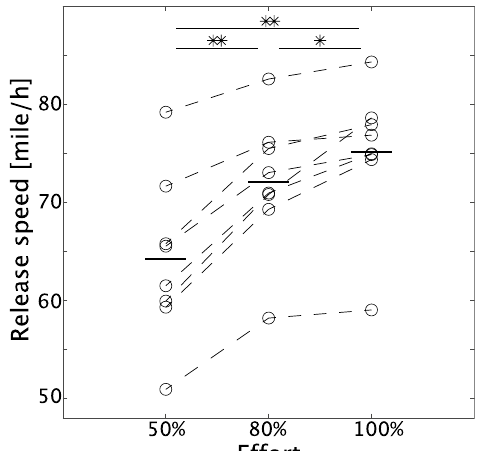
Figure 2. Ball-release speed in each level of effort. The horizontal solid black lines indicate the release speed averaged across all the trials and subjects in each condition (N = 8). Each circle represents the release speed averaged across all the trials in each subject. Each dotted black line indicates ball-release speed in each subject and effort. Single and double asterisks show statistically significant differences with p < 0.05 and p < 0.01 in Tukey’s comparison test.